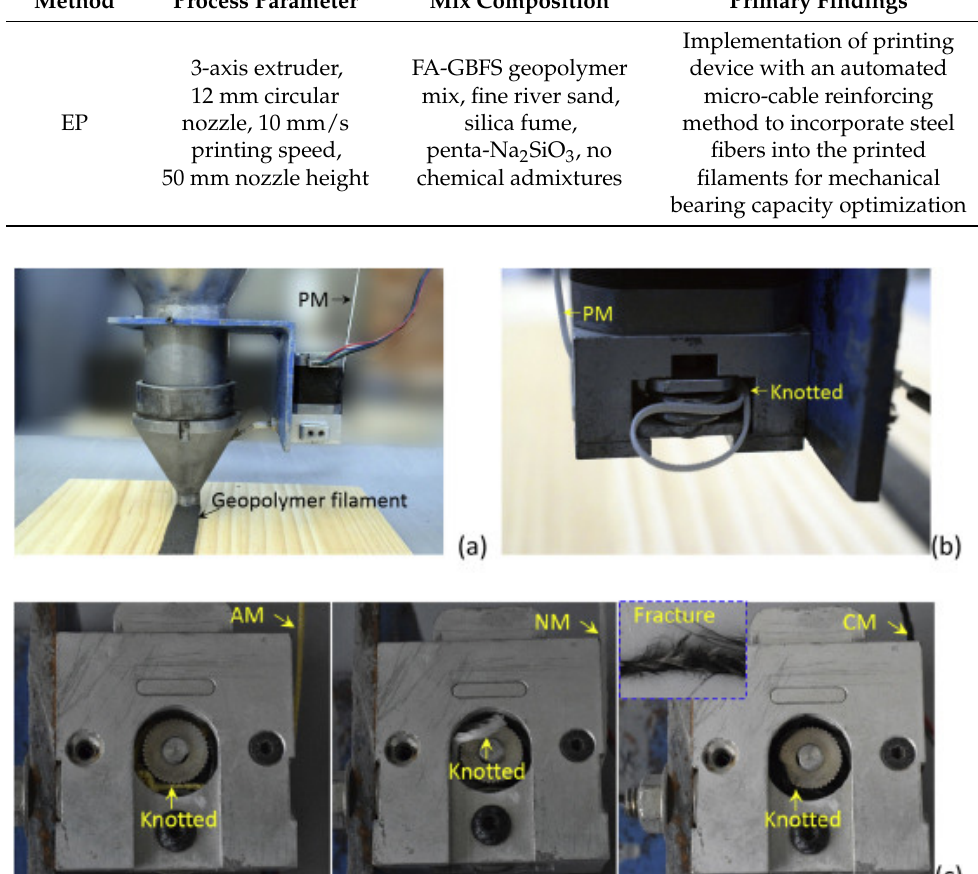
Figure 17. Extrusion 3D printing system implemented with micro-cable reinforcing device (repro- duced with permission from Li et al., Composites Part B: Engineering ; Elsevier, 2020).